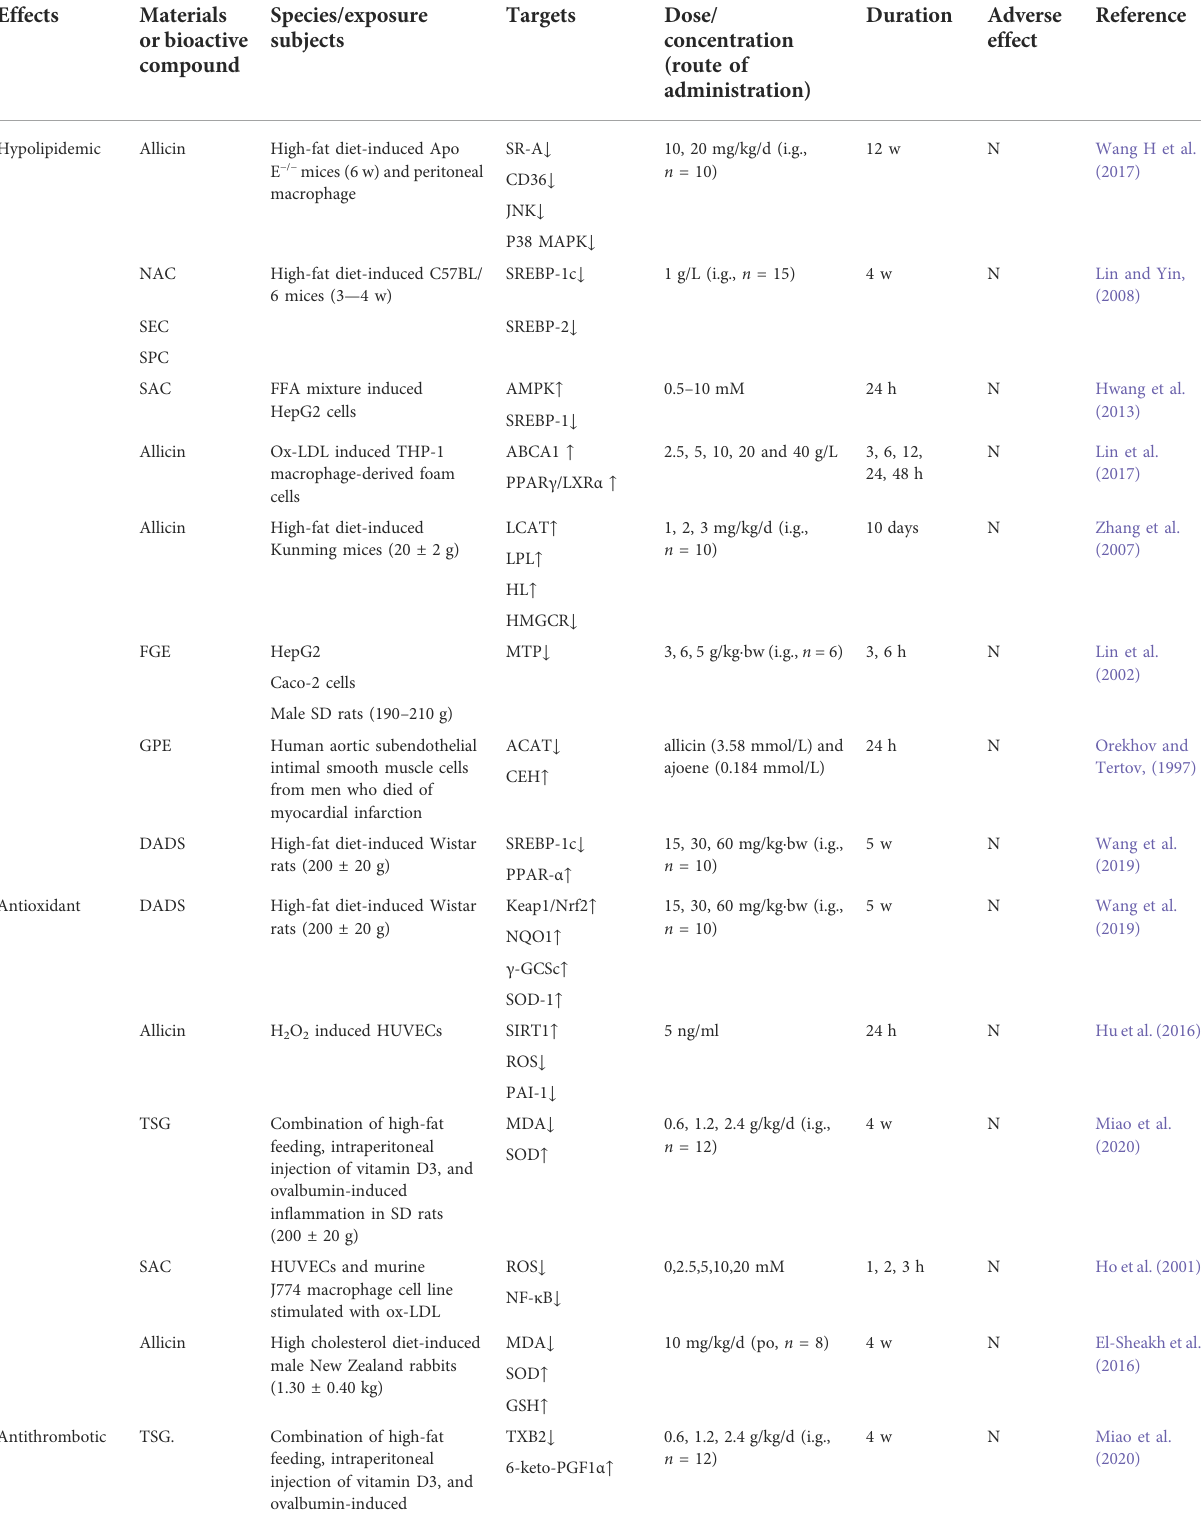
TABLE 1 Major effects and targets of garlic in